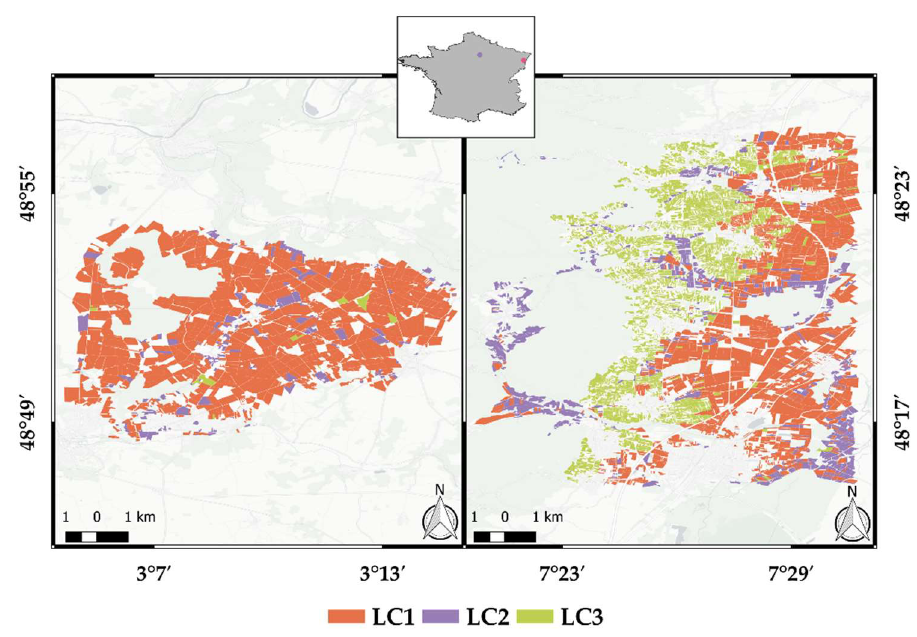
Figure 1. Location of the two study sites situated in France. LC1 represents cereal grains, LC2 meadows, and LC3 orchards and vineyards.